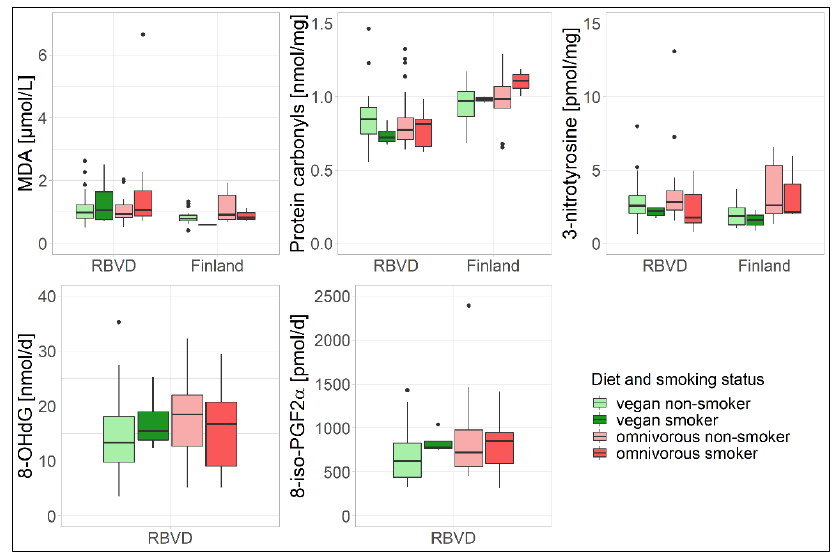
Figure 2. Boxplots of the oxidative damage biomarkers stratified by dietary group and smoking status in the RBVD and the Finnish study. Dots represent extreme values. No significant differences were observed for the interaction term of diet with smoking (Tables S1 and S2).